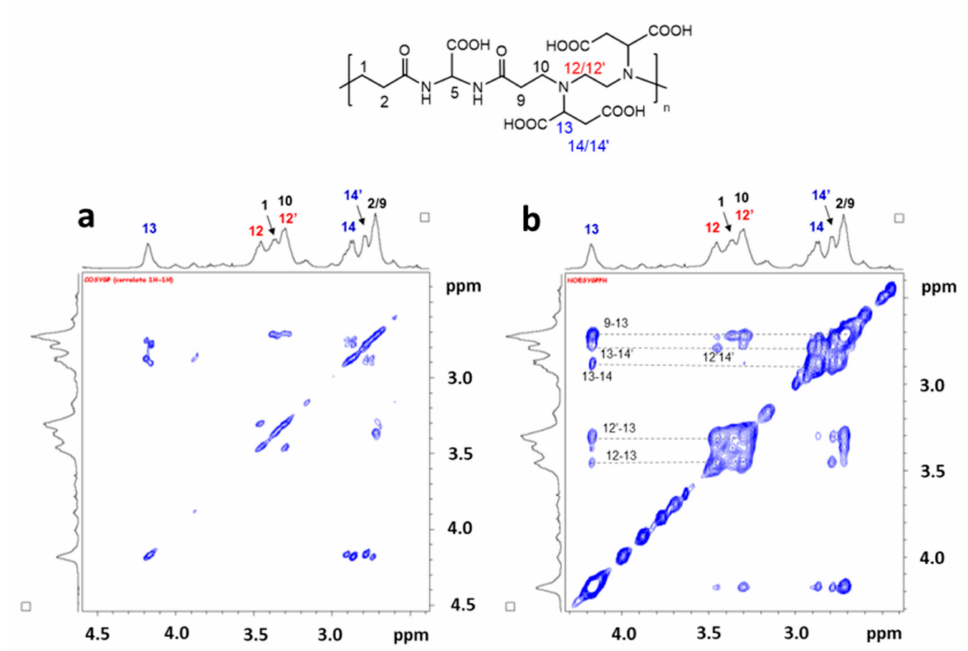
Figure 3. Aliphatic region of 2D NMR: ( a ) 1 H COSY and ( b ) 1 H NOESY experiments on a sample of BAC-EDDS homopolymer (D 2 O, 300 K, 9.4 T, pH =